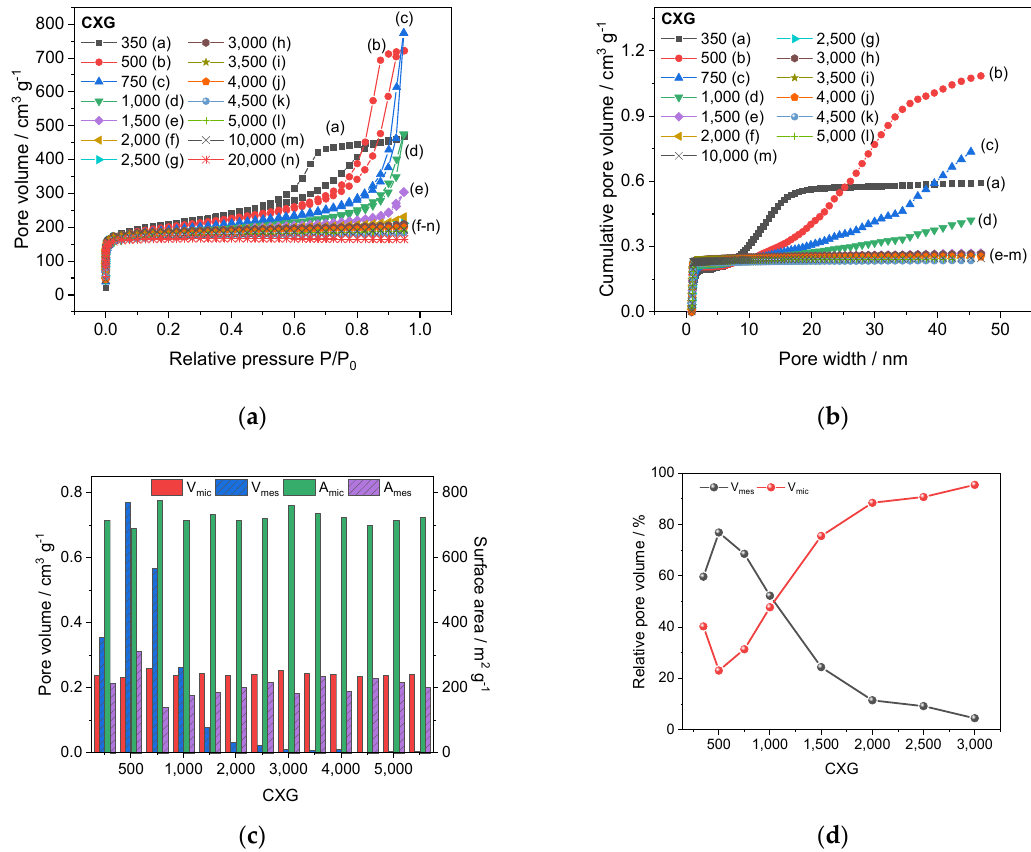
Figure 2. Characterisation of CXG by isotherms ( a ), pore size distribution with respect to V sum ( b ), contribution of microporous and mesoporous pore volume and surface area ( c ) and repartition of relative mesopore and micropore volume ( d